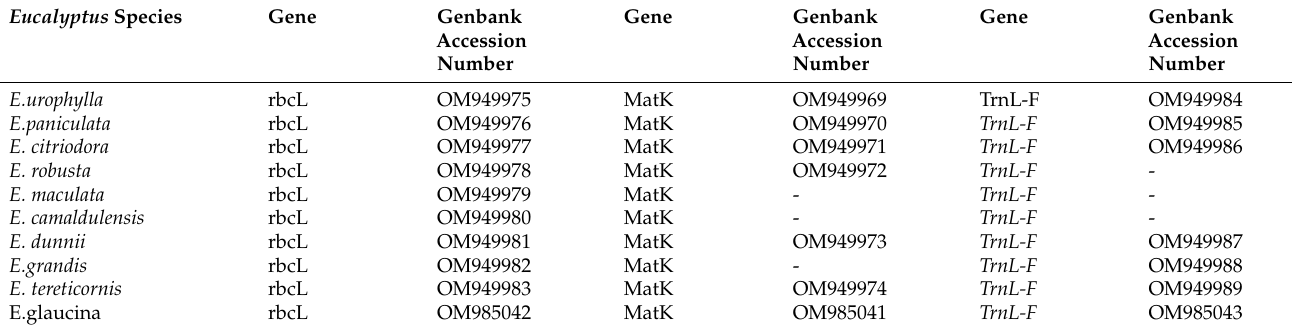
Table 2. Eucalyptus species Genbank accession numbers.